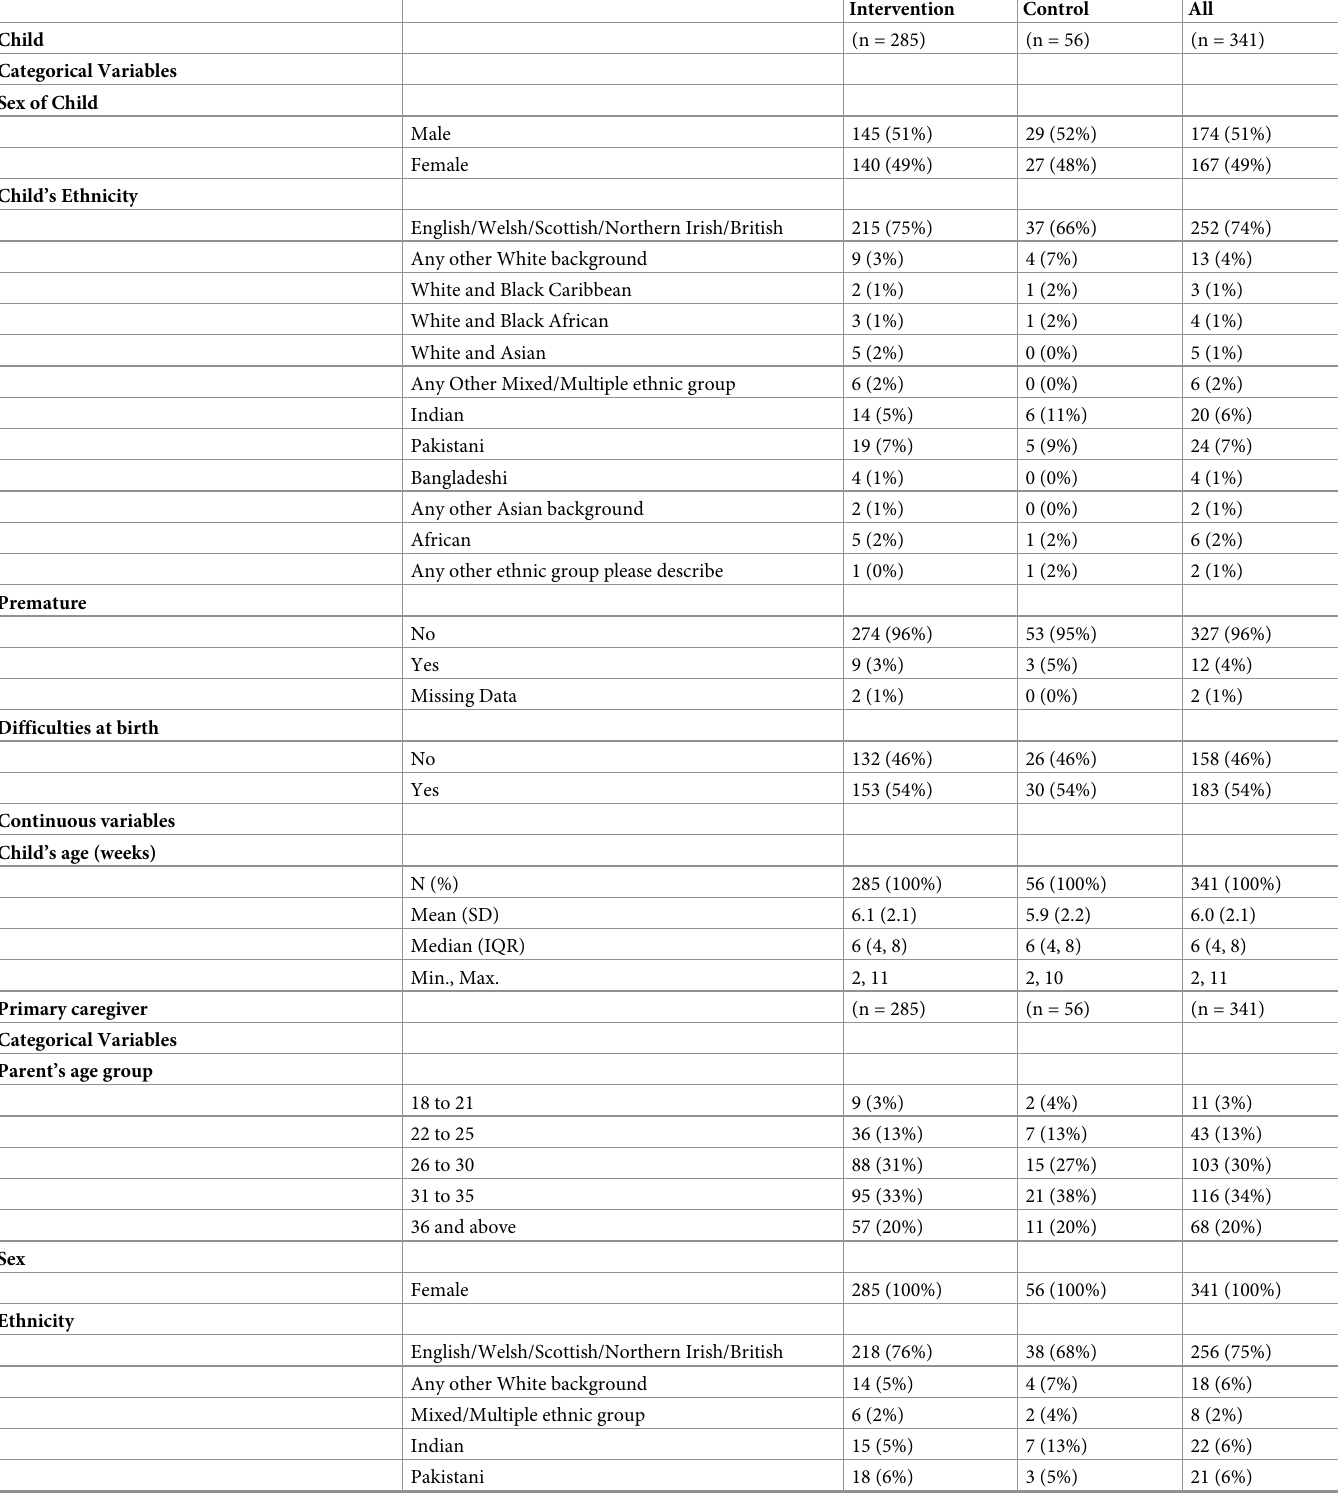
Table 1. Baseline demographic characteristics of child and primary